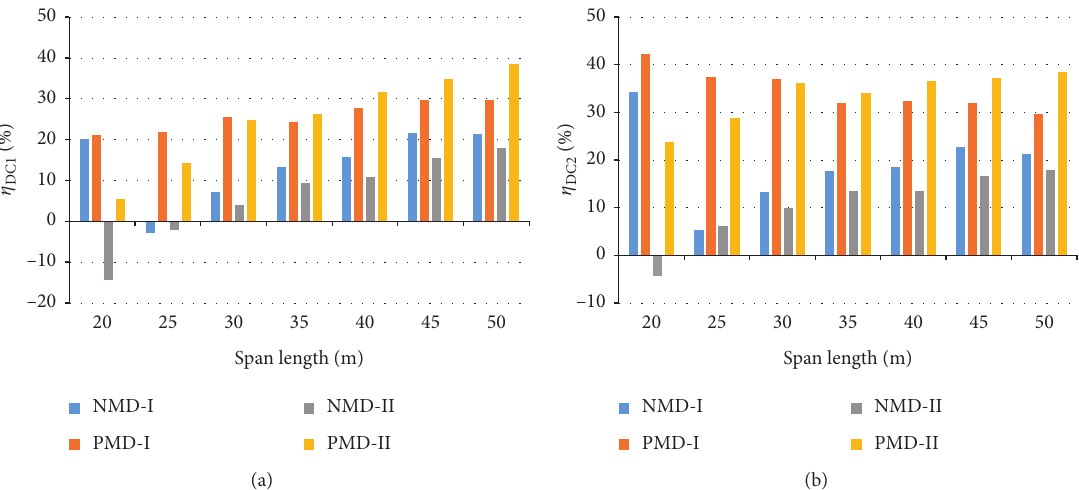
Figure 13: Comparison of the traffic loading effects of five-span continuous girder bridges with the dynamic load allowance: (a) η η DC2